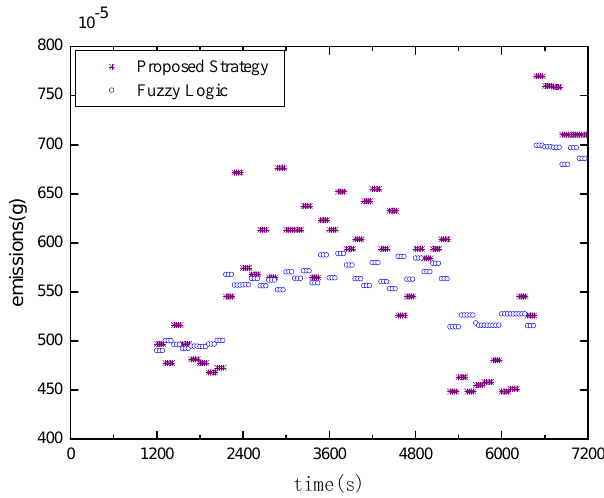
Figure 8. Comprehensive emissions comparison of the two compared